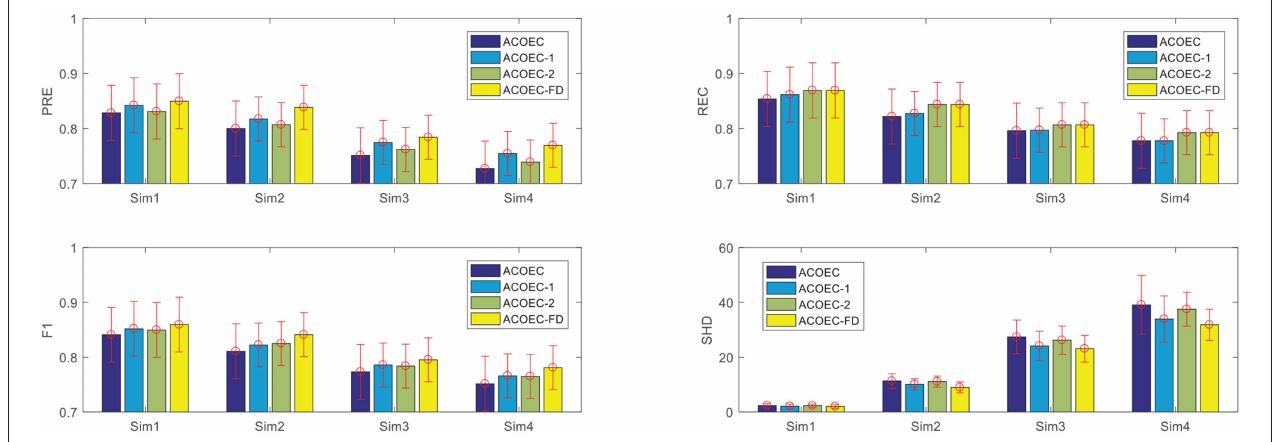
FIGURE 5 | Contributions of two new strategies for ACOEC. Horizontal axis corresponds to the four simulation data sets, vertical axis corresponds to the four measurements on each simulation. Error bars represent standard deviation for the given metric over 10 runs.